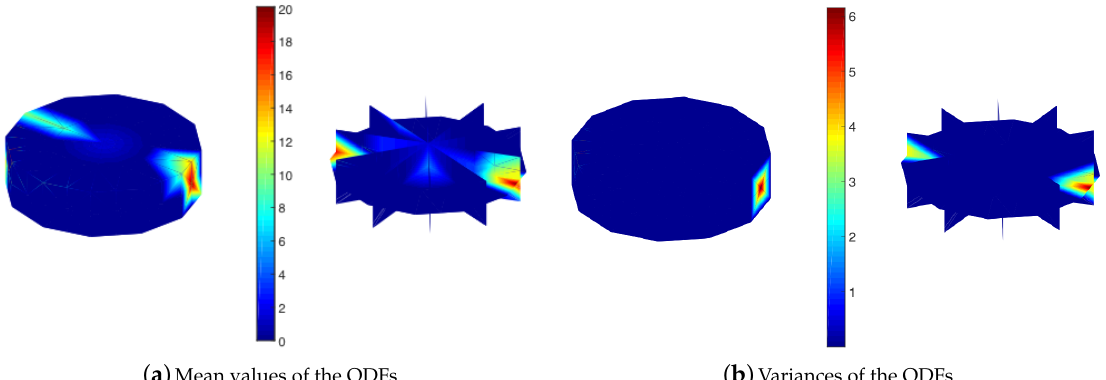
Figure 3. Initial solution for the uncertainty in microstructural